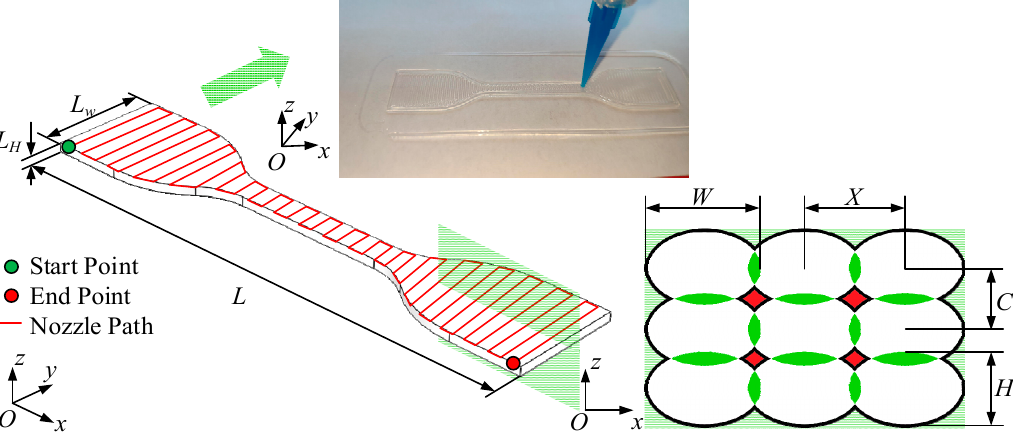
Figure 7. Silicone dumbbell specimen size and cross-sectional fill strand size. X , C , W , and H represent the fill strand spacing, the layer height, the strand width, and the nozzle height in the first layer, respectively. L = 115 mm, L W = 25 mm, L H = 2 mm.